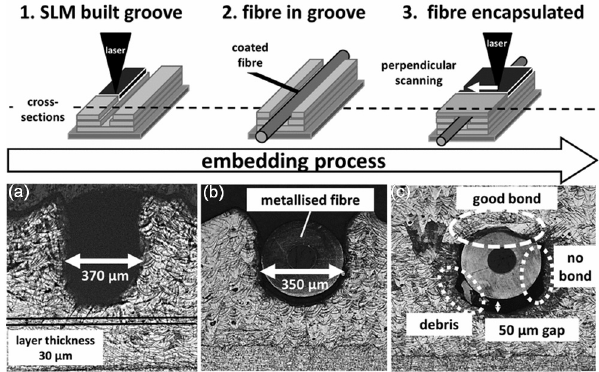
Figure 18. U-shaped groove built with SLM on SS 316 substrates ( a ), inserting Ni coated optical fiber inserted in the groove ( b ) and final encapsulation by continuing SLM process ( c ) [86].